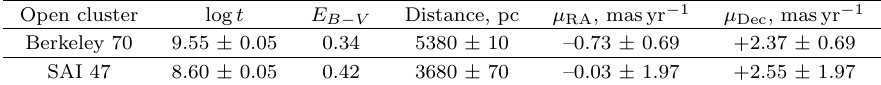
Table 3. Physical parameters of Berkeley 70 and SAI